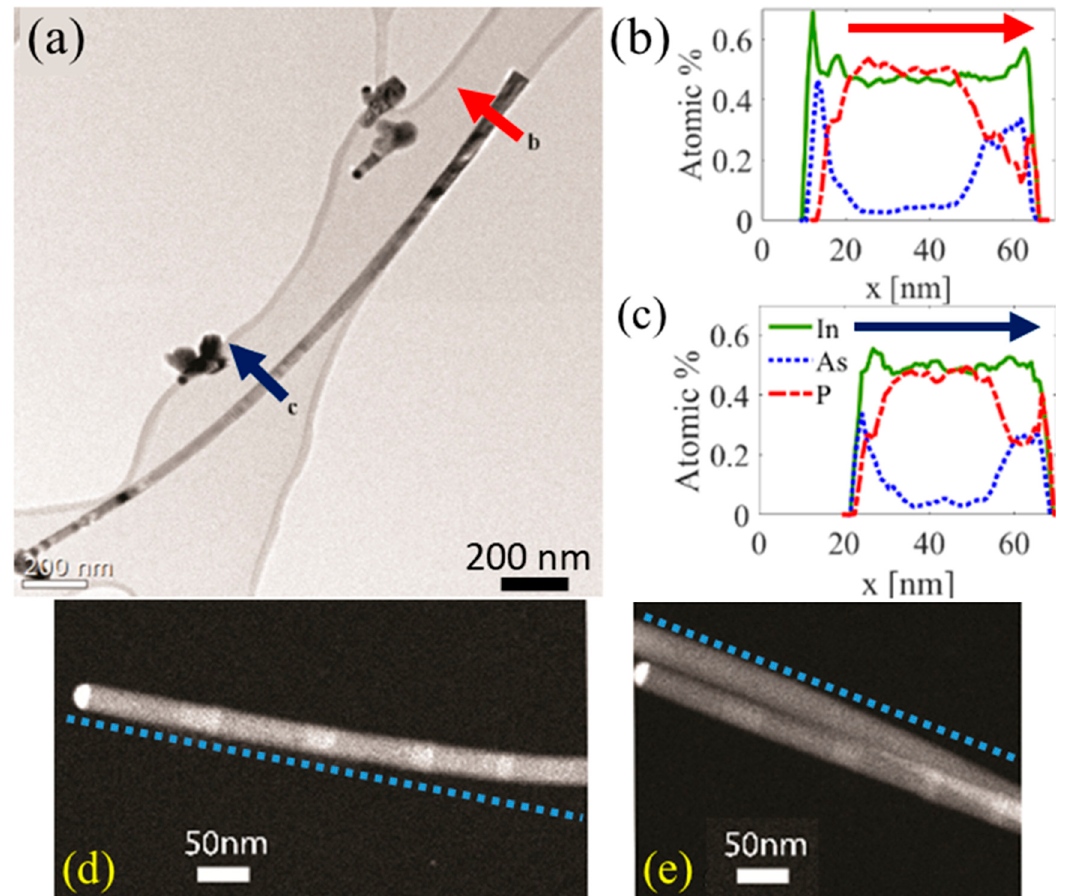
Figure 4. ( a ) TEM image of a bent InP–InAs heterostructure NW. ( b,c ) Energy-dispersive X-ray (EDX) analysis of the wire cross section at ( b ) wire base and ( c ) wire middle. Arrows show scan direction. ( d,e ) High-resolution TEM (HRTEM) scans of NW heterostructures showing further bending in addition to the creation of axial InAs segments. Dashed lines are a guide to the eye.